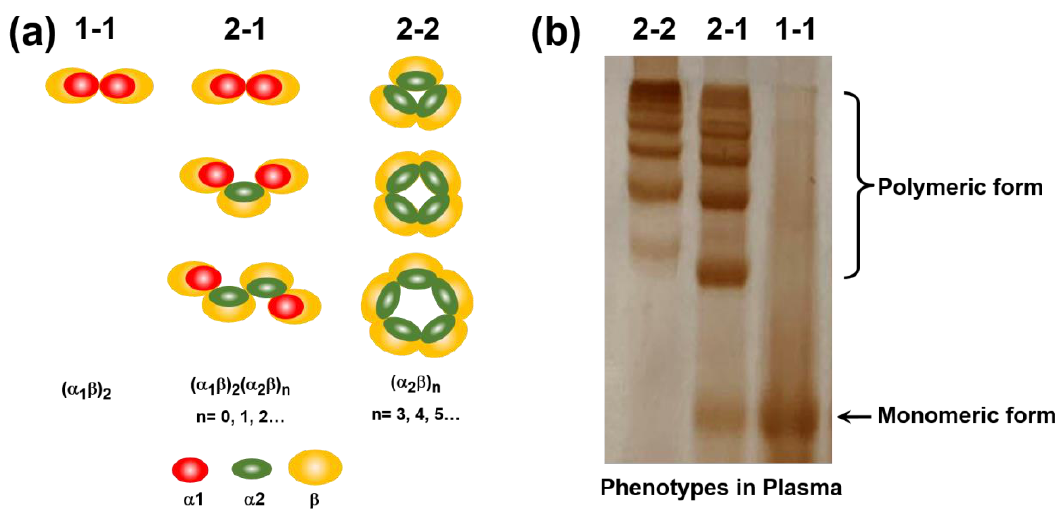
Figure 6. ( a ) Schematic illustration of haptoglobin (Hp) phenotypes of Hp 1-1, Hp 2-1, and Hp 2-2; ( b ) native-PAGE of plasma phenotypes of Hp 1-1, Hp 2-1, and Hp